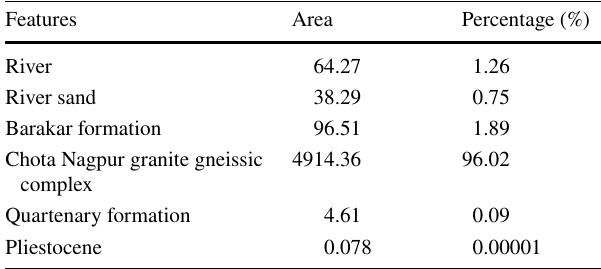
Table 6 Area statistics of